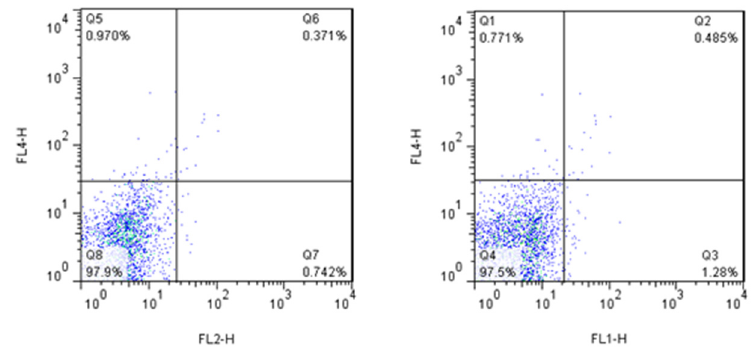
Figure 7. Dot-plots of cells stained with control isotype antibodies . Figure 8. Dot-plots of cells stained with control isotype